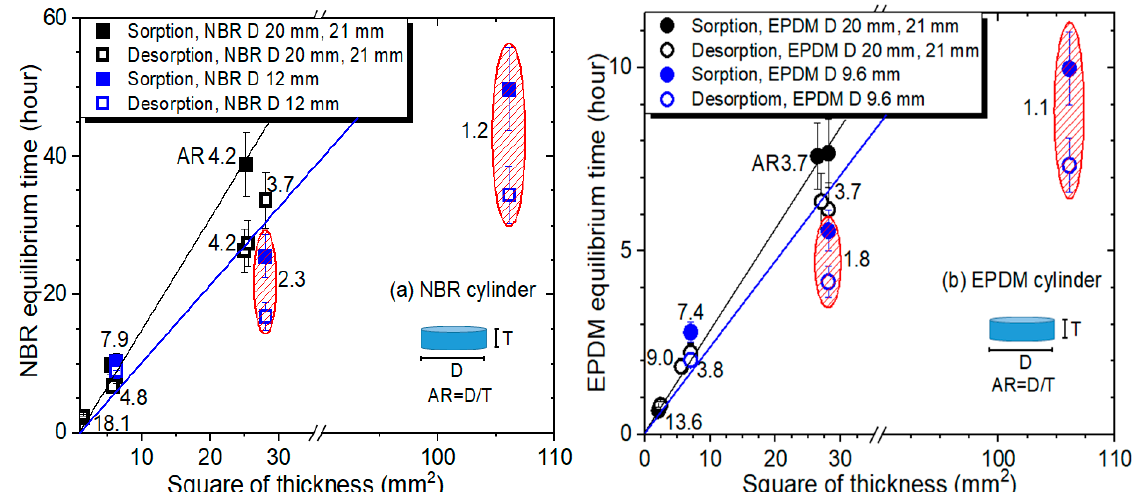
Figure 9. Saturation time for the sorption equilibrium and desorption equilibrium versus the square of the thickness for ( a ) NBR and ( b ) EPDM. The number indicates the aspect ratio (AR) of the cylin- drical rubber. D indicates diameter of the cylindrical